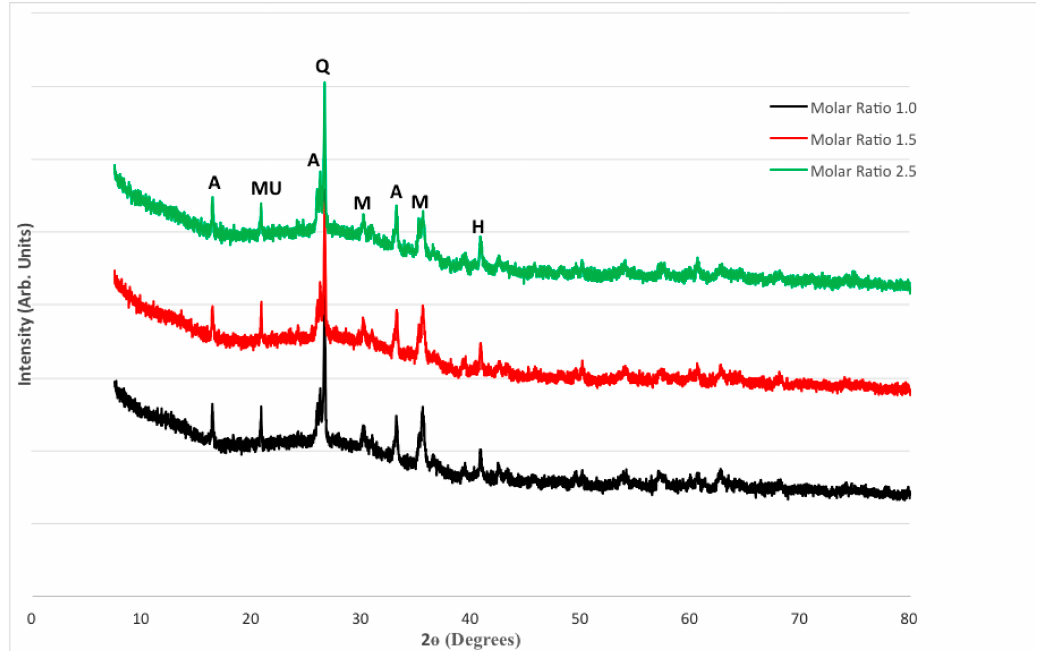
Figure 10. XRD Patterns for FA-based geopolymers.